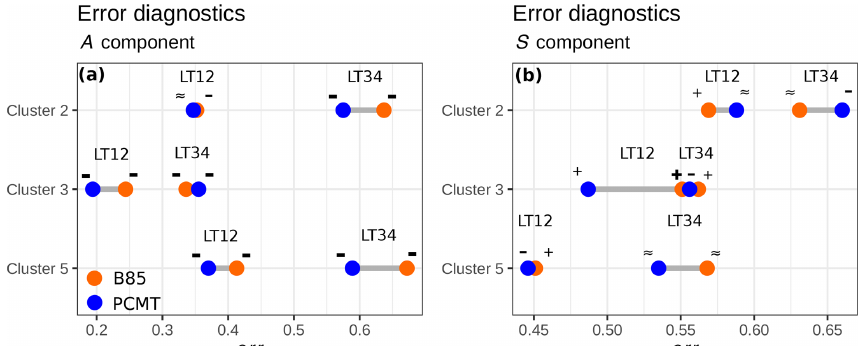
Figure 10. Dumbbell plot of integrated error diagnostics computed using Eq. (11). Colours refer to B85 (orange) and PCMT (blue) deep- convection parametrization schemes. Results are stratified on the basis of the clusters and lead times. Symbols denote whether positive or negative errors dominate. These signs are defined using the following definition: − (bold) if err − ≤ 0 . 9; + (bold) if err − ≤ 0 . 1 . 1; + if 0 . 5 < err − err + err +